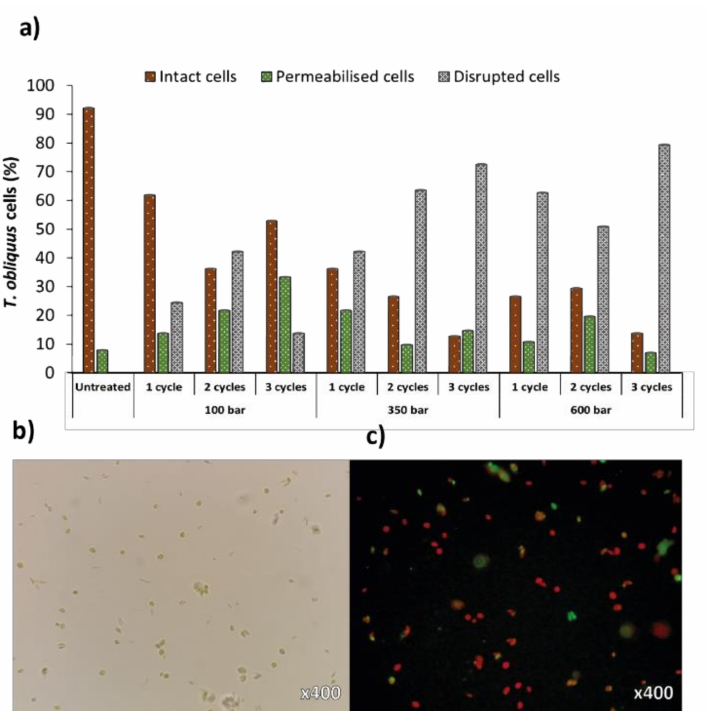
Figure 4. ( a ) Percentages of intact, permeabilised and disrupted cells of Tetradesmus obliquus after high-pressure homogenization at different pressure or cycles, estimated from microscopic analyses. Examination of ( b ) optical and ( c ) fluorescence microscopy using Tetradesmus obliquus stained with SYTOX Green after high-pressure homogenization treatment using 350 bar/2 cycles. Red-coloured cells are due to chlorophyll fluorescence (intact cells); green-coloured cells are due to SYTOX Green staining (permeabilised